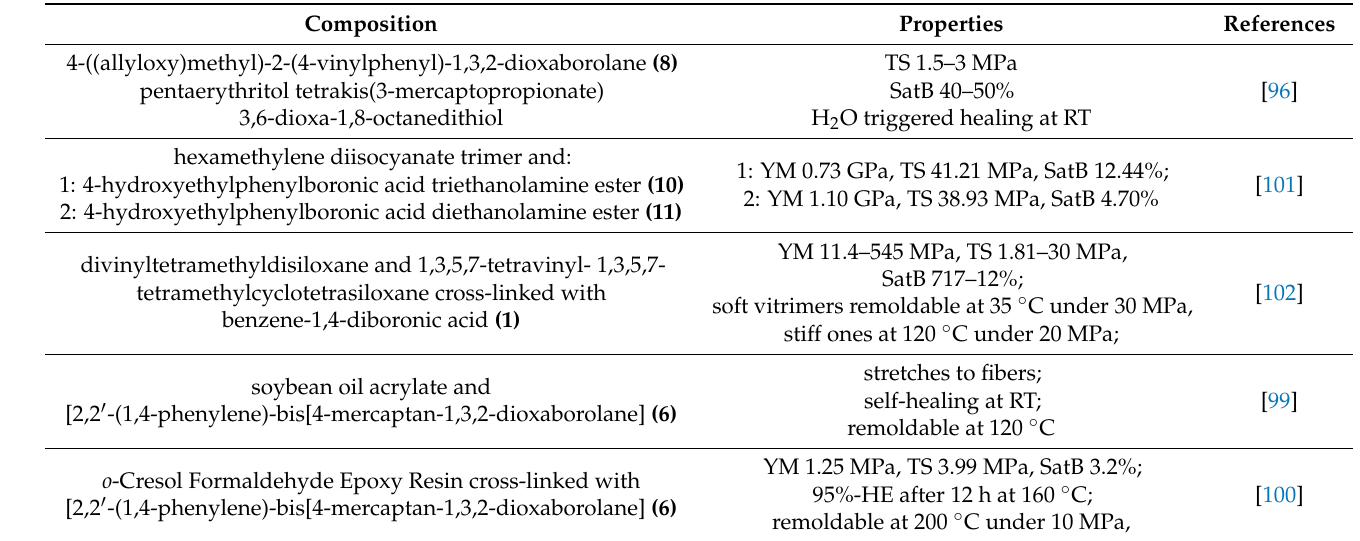
Table 2. An overview of dynamic networks synthesized small molecules resins cross-linked with boronic acid esters dynamic